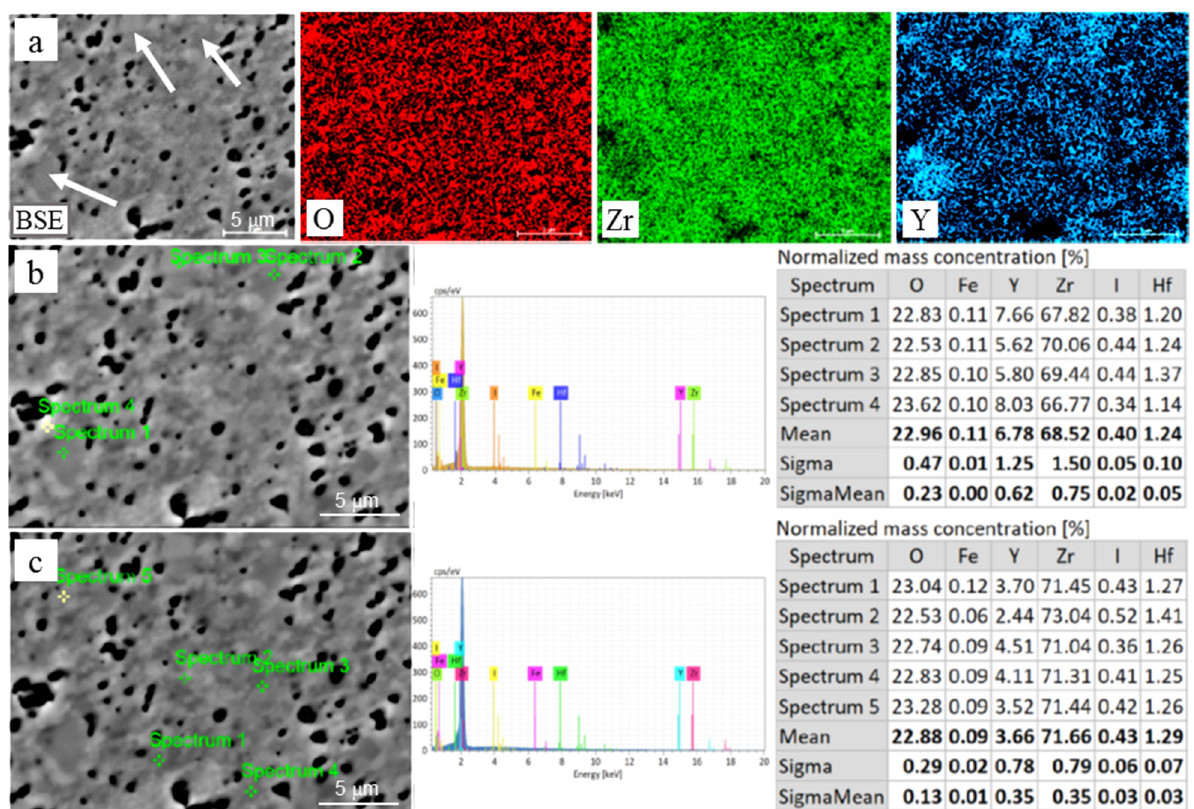
Figure 5. Chemical analysis of 3YSZ material: ( a ) SEM–EDS maps for O, Zr, and Y, showing grains enriched in Y (white arrows); quantitative analysis of ( b ) coarse and ( c ) fine grains with correspond- ing EDS spectra and concentration tables.